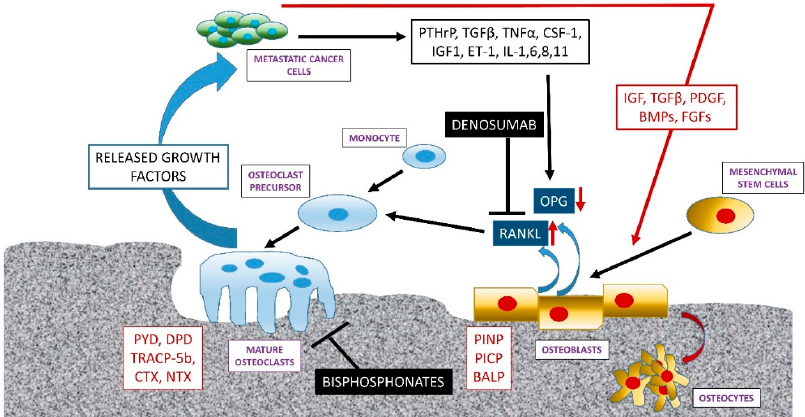
Figure 1. General mechanisms of altered bone homeostasis within bone metastatic cancers.